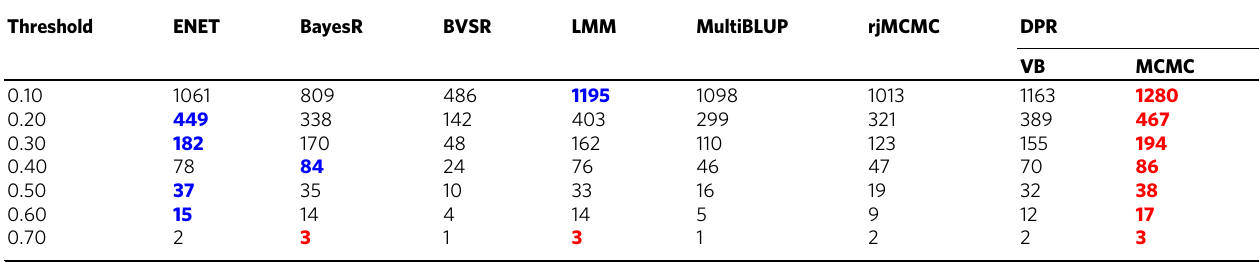
Table 1 Comparison of seven different methods in predicting gene expression levels in the GEUVADIS data